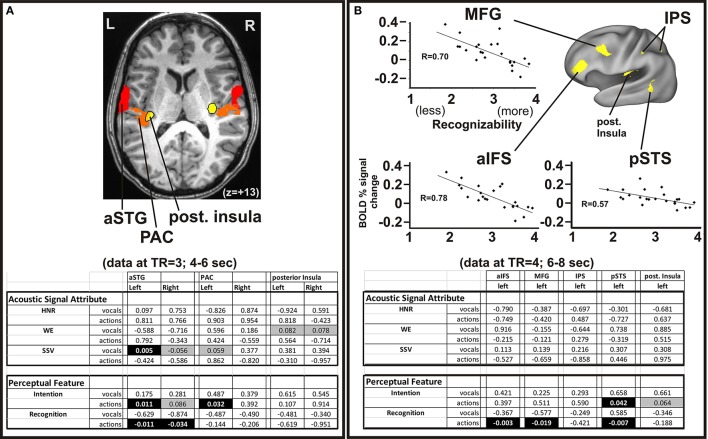
Parametric activation analyses related to the acoustic signals and perceptual attributes of the animal sounds. (A) The group-averaged datasets from Figure 2 are superimposed on an axial section of one participant (Talairach z = +13) showing the divergent processing regions (yellow vs. red) in both hemispheres. Multiple linear correlation p-value fits between regions of interest with the quantifiable high-order acoustic signal attributes (HNR, WE, SSV) and perceptual features (Intention, Recognition) of the animal action sounds and vocalizations (from Table 1) at the brain imaging time phase of TR = 3, occurring 4–6 s after sound onset. Negative correlations are indicated by negative value entries. Cells with black highlighting depict p < 0.05 (significant), and cells with gray highlighting depict p < 0.09 (trending). (B) Top panels show linear correlation charts for three of the five left hemisphere ROIs (MFG, aIFS, and pSTS; also evident in Figure 2). Charts illustrate BOLD percent signal change activation relative to acoustic signal attributes and perceptual ratings as in Panel A, except at the brain imaging time phase of TR = 4, occurring 6–8 s after sound onset. Lower panel shows results from a multiple linear regression analysis (correlation p-value fits) for all five ROIs sensitive to animal action sounds. Refer to Methods for further details.